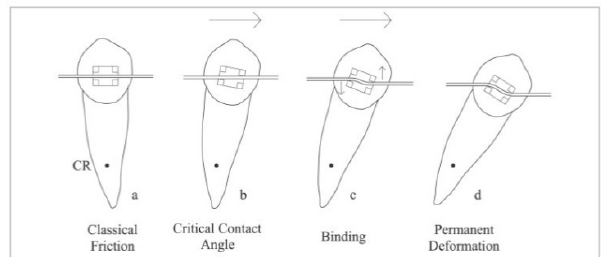
Figure 3. Friction, binding, and notching [22].